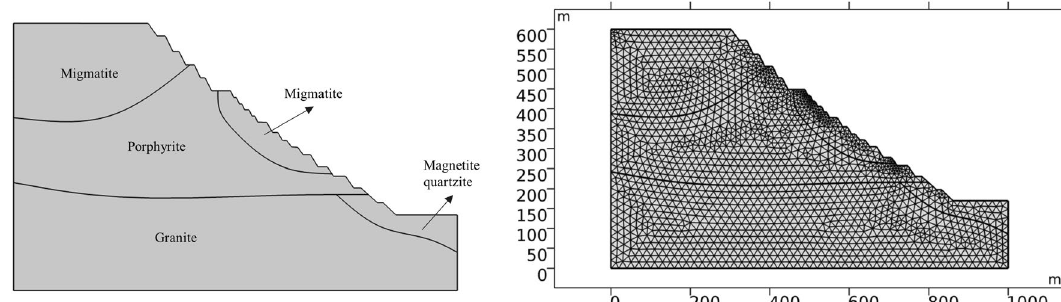
Figure 12. Strata and Calculation model of the slope. Rock